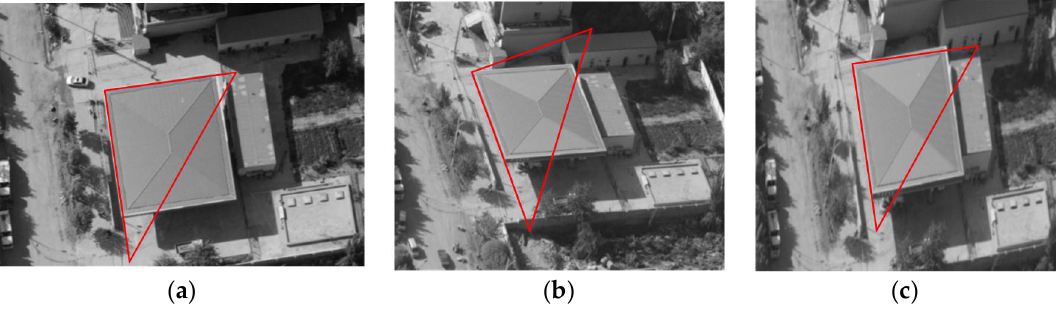
Figure 3. Perspective distortion and rectification of the rectangular buildings: ( a ) the regular rectangle taken by down-looking camera; ( b ) the deformation under a back-looking camera; ( c ) the rectified rectangle of the deformed image.